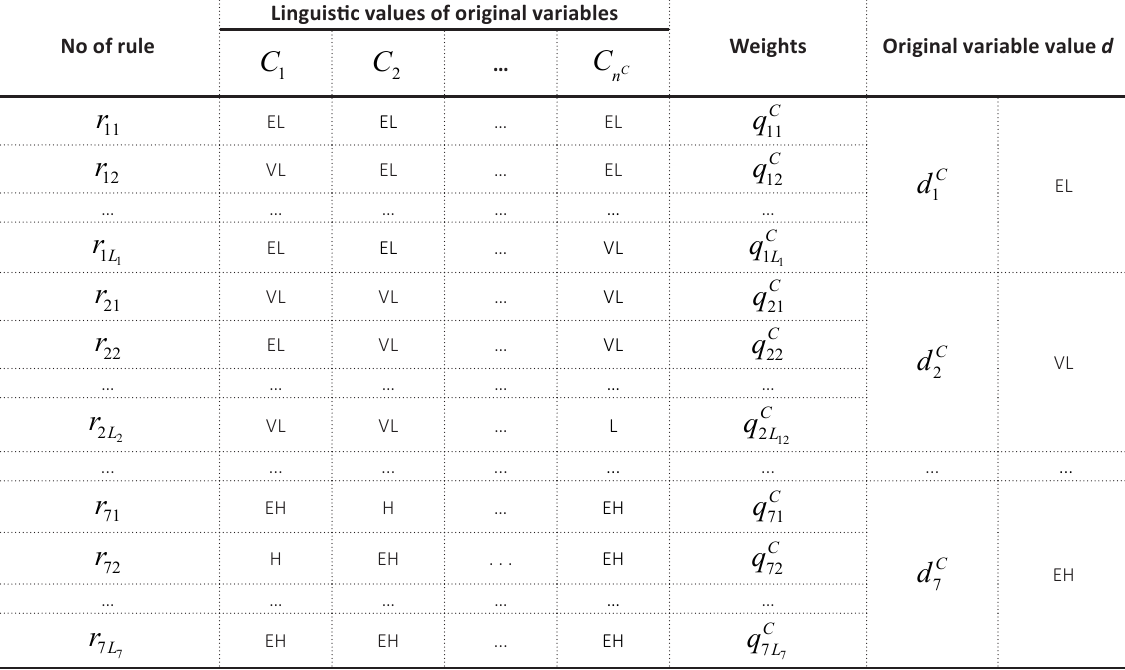
Figure 3. The system structure of Mamdani fuzzy inference Table 4. Section of the FKB (C) – fuzzy knowledge base to determine the level of ideas’ commercial potential according to the sub-criteria of criterion C – ‘creativity’